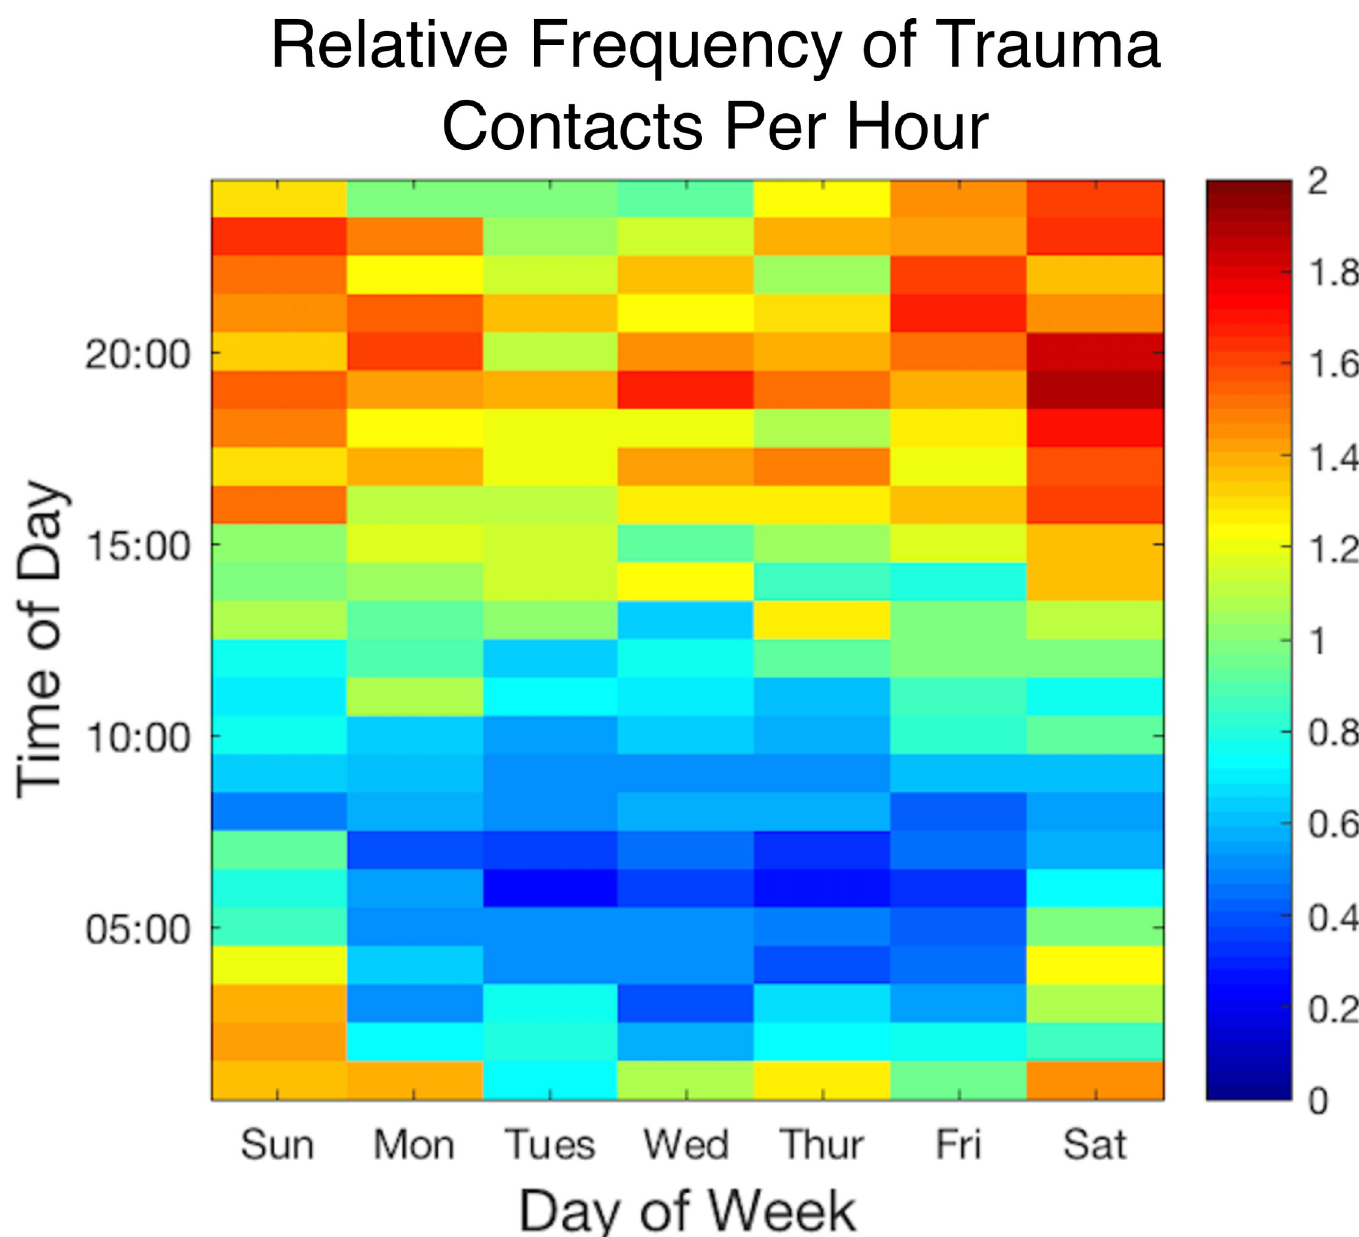
Fig 1. Heatmap of trauma admissions by time of day versus day of week. Each block of the heatmap represents a one hour block of one day of the week over the three year study period. The color corresponds to the relative frequency of contacts per hour as described by the color bar to the right of the image, where 1 represents the mean number of trauma contacts per hour. Weekend days have more trauma than weekdays, P < 0.001. Mornings (4AM– 8AM) have less trauma than evenings (4PM– 8PM) on all days of the week, P < 0.001.